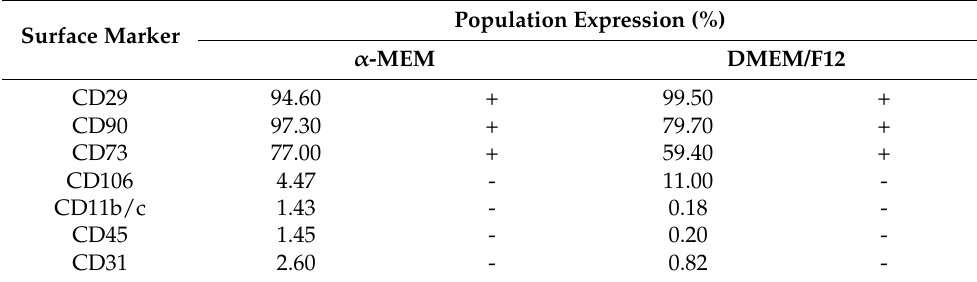
Figure 2. Alamar Blue proliferation data for rDPSC populations cultured in α -MEM-, both enzymatic and tissue outgrowth methods, and DMEM-based growth mediums. Table 4. Flow cytometry data for α -MEM and DMEM/F12 cultured